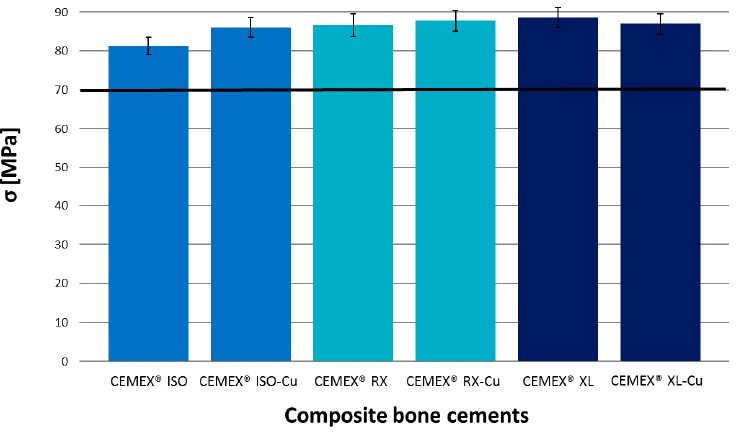
Figure 6. Compression strength evaluation of composite cements and commercial samples in accordance with ISO 5833-2002 standard. Bars represent means and standard deviations.